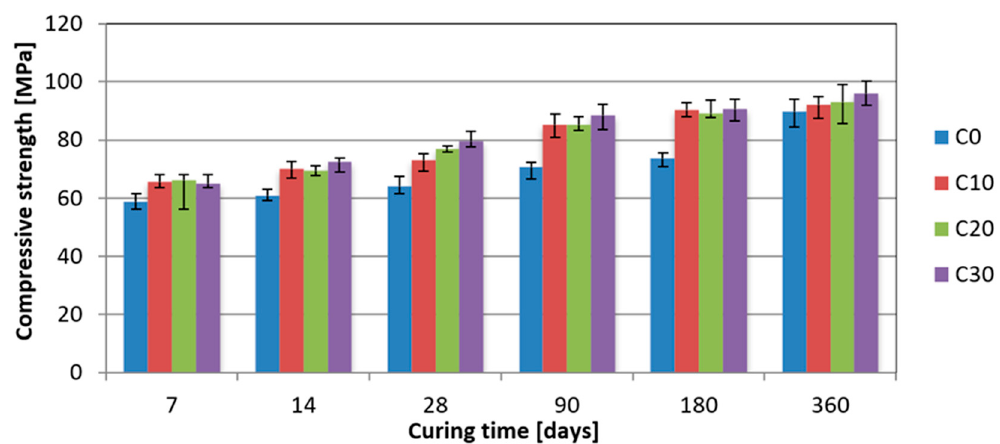
Figure 7. Compressive strength of concrete as a function of time and content of basalt dust as sand replacement (C0–reference concrete, C10–C30–concrete with additive of basalt dust replacing 10–30% of sand).